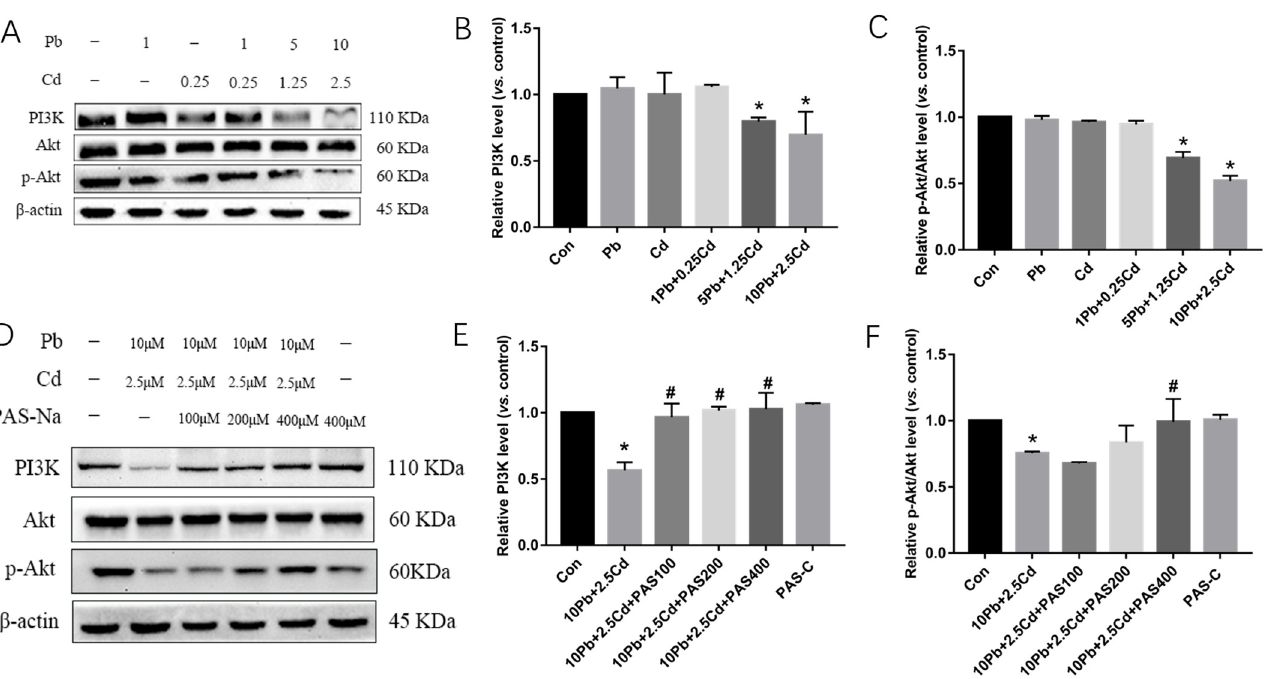
Figure 3. Effects of lead and cadmium on PI3K/Akt in SH-SY5Y cells, and effects of PAS-Na on the expression of PI3K and Akt exposed to lead and cadmium. ( A , D ) Western blot results; ( B , E ) PI3K expression; ( C , F ) p-Akt/Akt ratio. An amount of 1 Pb is 1 μ mol/L Pb, and 0.25 Cd is 0.25 μ mol/L Cd. An amount of 1 Pb + 0.25 Cd is 1 μ mol/L Pb + 0.25 μ mol/L Cd mixture, 5 Pb + 1.25 Cd is 5 μ mol/L Pb + 1.25 μ mol/L Cd mixture, 10 Pb + 2.5 Cd is 10 μ mol/L Pb + 2.5 μ mol/L Cd mixture. *, p < 0.05 compared with the control. #, p < 0.05, compared with the 10 Pb + 2.5 Cd. Data are presented as mean ± SD.